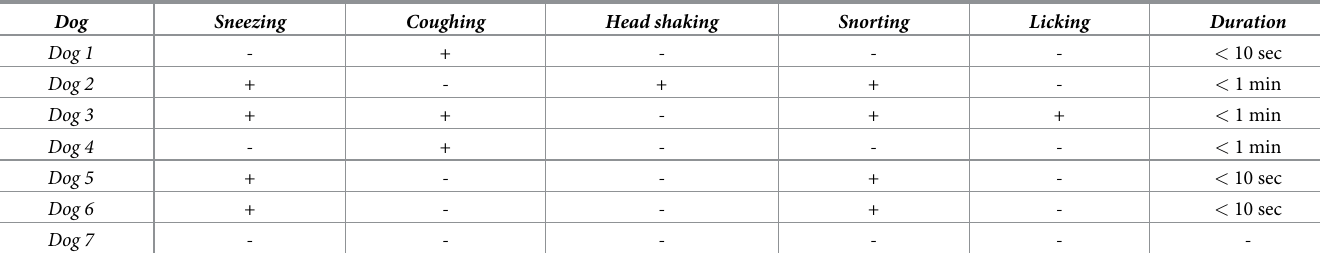
Table 3. Adverse reactions following intranasal administration of 2 mg/kg BW racemic ketamine in the individual dogs (n = 7). Dog